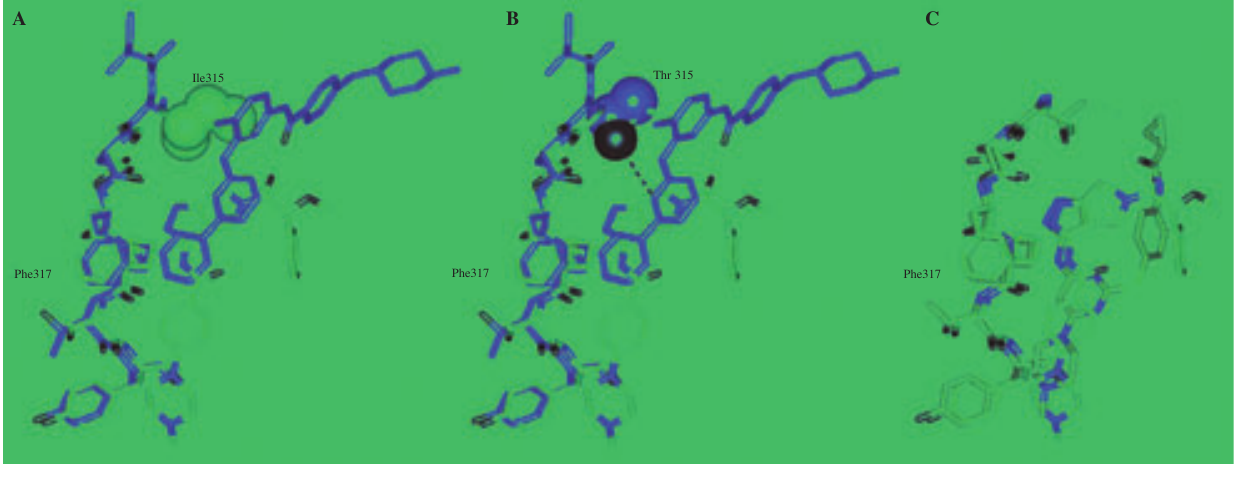
Figure 6. Comparison of PHA-739358 complex with imatinib and MK-0457 complexes. (A) and (B) PHA-739358 complex (green carbon atoms) superimposed with the structure of imatinib (magenta carbon atoms). The gatekeeper residues Ile315 of PHA-739358 complex (A) and Thr315 of the imatinib complex (B) are shown with van der Waals spheres. In the T315I mutant, the isoleucine side chain causes a steric clash with imatinib; in addition, the hydrogen bond between imatinib and the side chain oxygen of threonine is lost. (C) Structure of Abl-PHA-739358 complex (green carbon atoms) superimposed on the structure of MK-0457. [Reprinted and adapted with permission of AACR from: Modugno M, et al. Crystal structure of the T315I Abl mutant in complex with the aurora kinases inhibitor PHA-739358. Cancer Res 2007 Sep